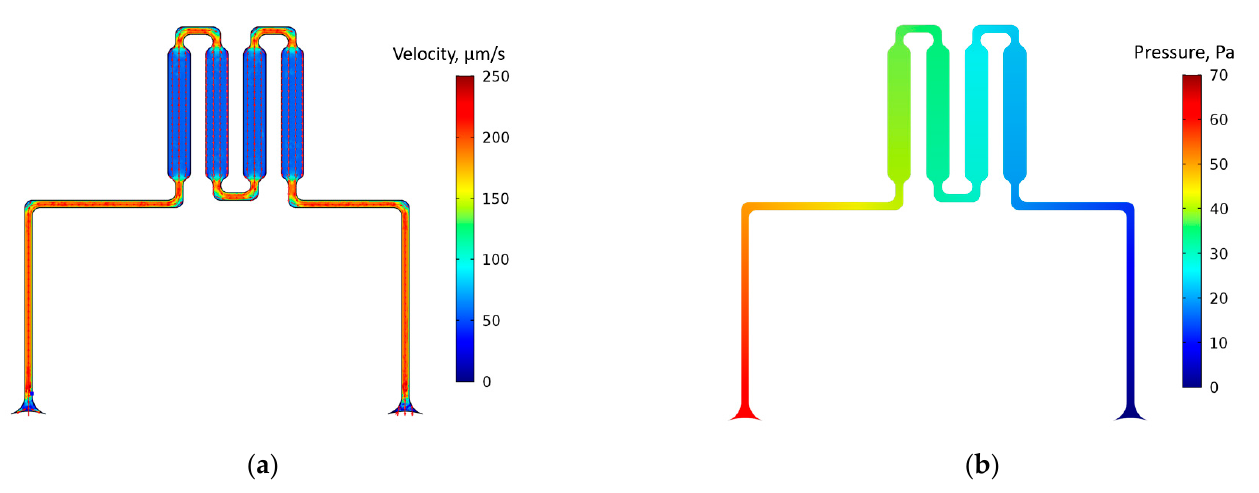
Figure 3. Velocity ( a ) and pressure ( b ) distribution in the microfluidic system.